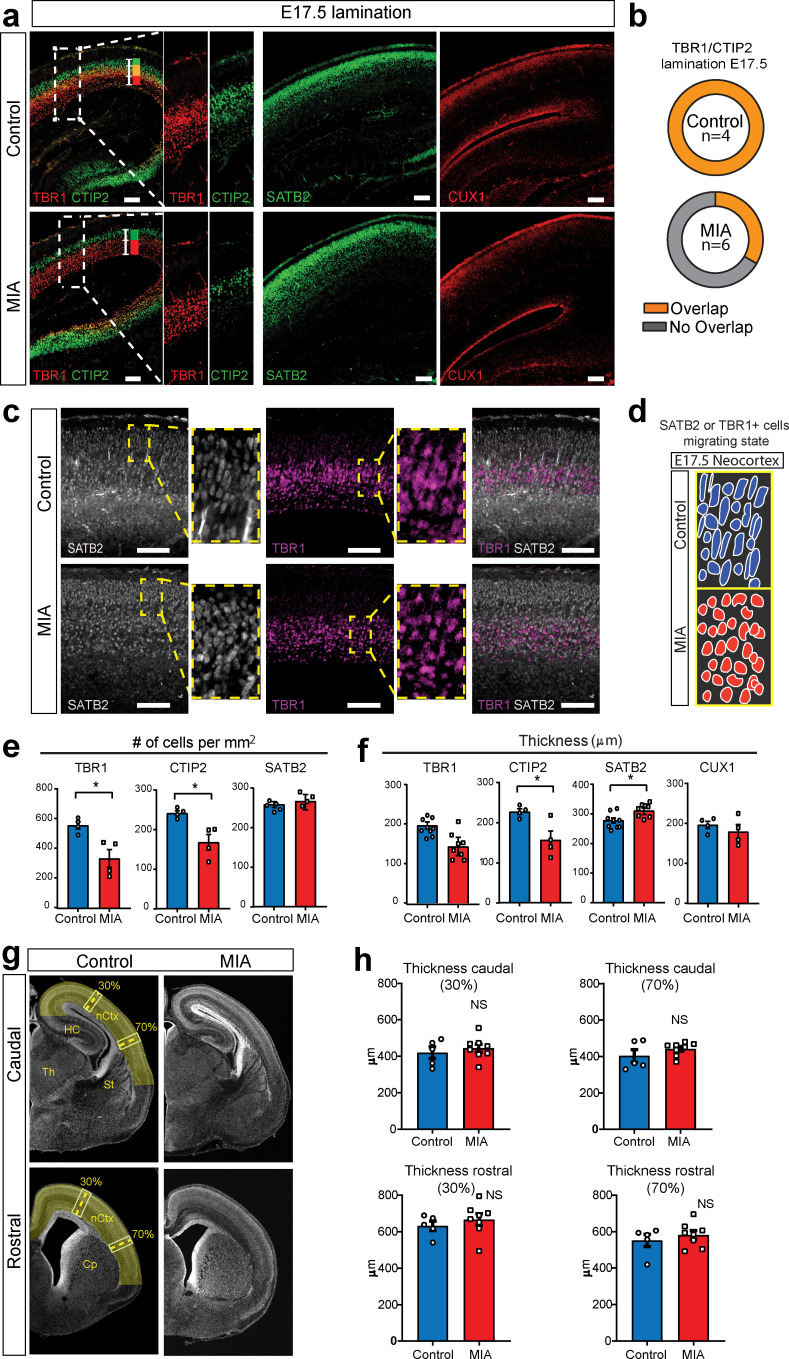
MIA impacts cortical lamination during development.(a) Coronal fetal brain sections from E17.5 saline (control) and MIA offspring show altered lamination pattern. Immunostaining using antibodies to identify deep cortical lamination layers using CTIP2 (green), and TBR1 (red) markers as well as markers of postmitotic neurons, SATB2 and CUX1, in more superficial cortical layers in brains derived from saline (control) or MIA injected dams. Representative images are shown. CTIP2/TBR1 overlap, represented by yellow color, was generally present in control brains, compared to fully laminated deep layers in MIA brains (no overlap illustrated by adjacent green and red rectangles). Boxes indicate magnified areas used for quantification and CTIP2/TBR1 overlap analyses. Scale bars = 100 µm. (b) TBR1/CTIP2 lamination overlap occurrence is present in all control brains but absent in the majority of MIA samples at E17.5. Brains from three MIA litters and two control litters were co-stained with TBR1 and CTIP2 cortical markers (as shown in a-b) and analyzed for lamination overlap occurrence (n = 4 control, n = 6 MIA). While all control brains showed lamination overlap between TBR1/CTIP2 layers, absence of TBR1/CTIP2 lamination overlap was observed in four out of six analyzed MIA brains. (c) Representative images of SATB2 and TBR1 staining at higher resolution show a change in cell morphology consistent with a difference in migration between MIA and control groups at E17.5. (d) Schematic representation illustrates the oval-radially migrating cell body shapes in control brains and the more rounded cell body shape in the MIA brains typical of static cells after migration. (e) MIA-induced reduction in TBR1+, CTIP2+, but not in SATB2+ cell counts (n = 4–5 brains per condition, TBR1 p=0.0138; CTIP2 p=0.0119; SATB2 p=0.306). (f) Significant decrease in CTIP2 and increase in SATB2 thickness indicates relative expansion of more superficial layers in MIA brains at E17.5 (Layer-specific thickness analysis: n = 4–8 per condition, TBR1 p=0.081; CTIP2 p=0.024; SATB2 p=0.039; CUX1 p=0.430, two tailed Student’s t-test). (g) Representative caudal and rostral coronal sections of E17.5 control and poly(I:C) brains stained with DAPI show no obvious cortical dysplasia or gross anatomy alterations. Yellow shading represents neocortical areas considered for thickness measurements. nCtx: neocortex, Th: thalamus, St: striatum, HC: hippocampus, Cp: caudate-putamen. (h) Quantification of cortical thickness measured at 30% and 70% distance from the dorsal midline and cortical hemispheric circumference indicates no differences in overall thickness of these neocortical regions (n = 5 control, n = 8 poly(I:C); caudal 30% p=0.5252; caudal 70% p=0.2481; rostral 30% p=0.4459; rostral 70% p=0.4583, two tailed Student’s t-test).